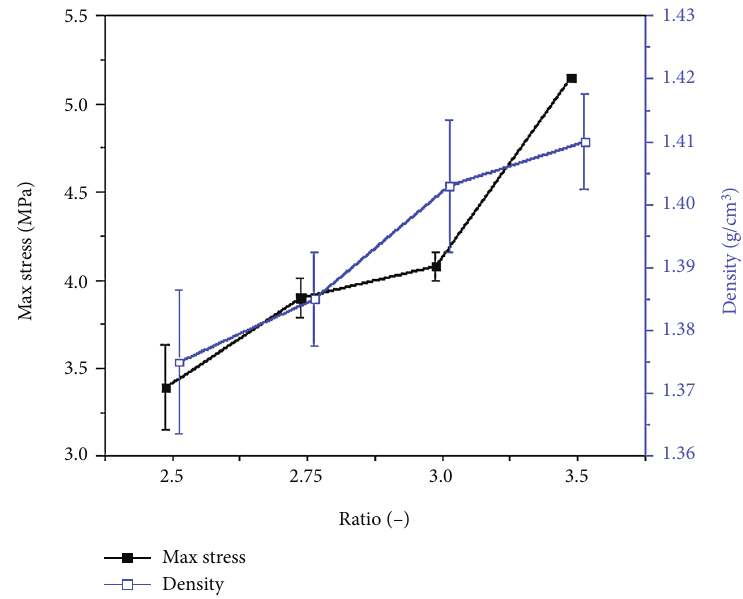
Figure 6: The plot of max stress and density for each type of